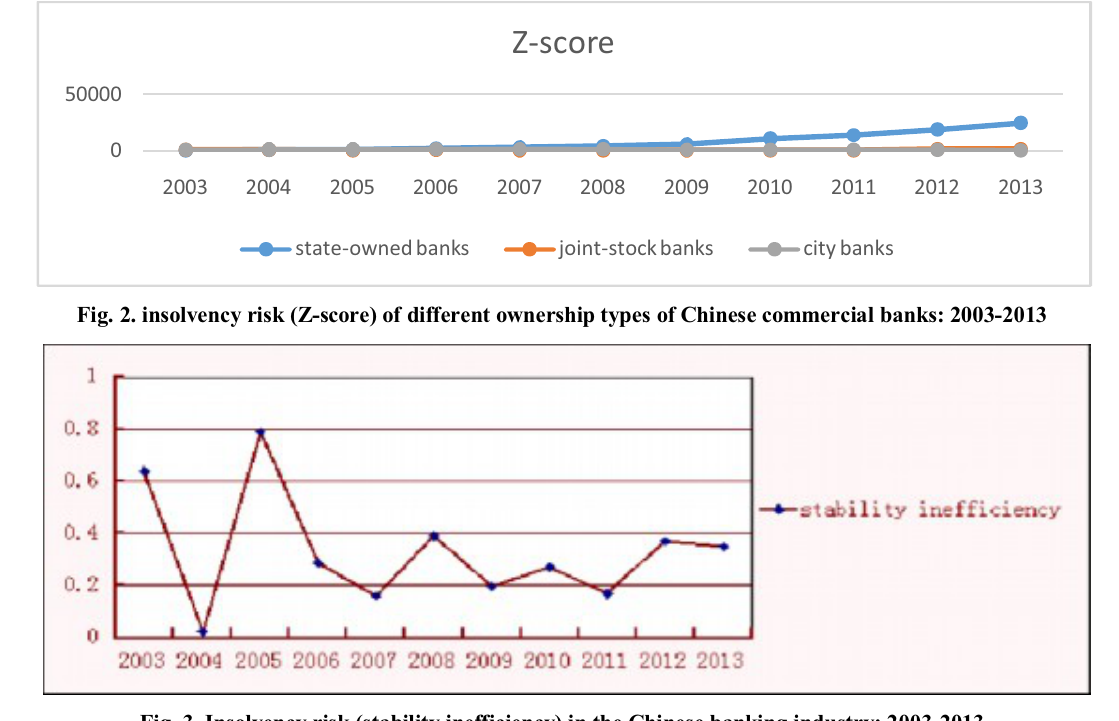
Fig. 3. Insolvency risk (stability inefficiency) in the Chinese banking industry: 2003-2013 Table 3. Unit root test for the